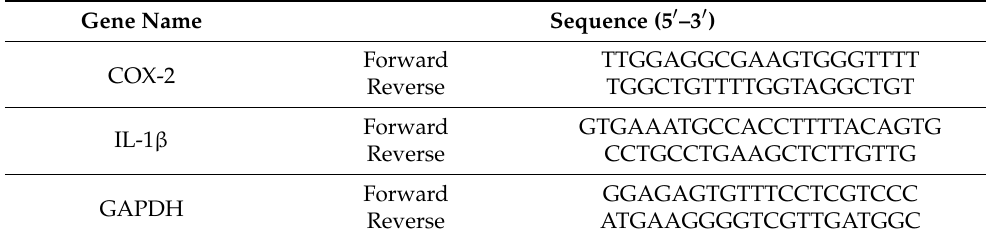
Table 4. Sequences of primers used for quantitative real-time PCR